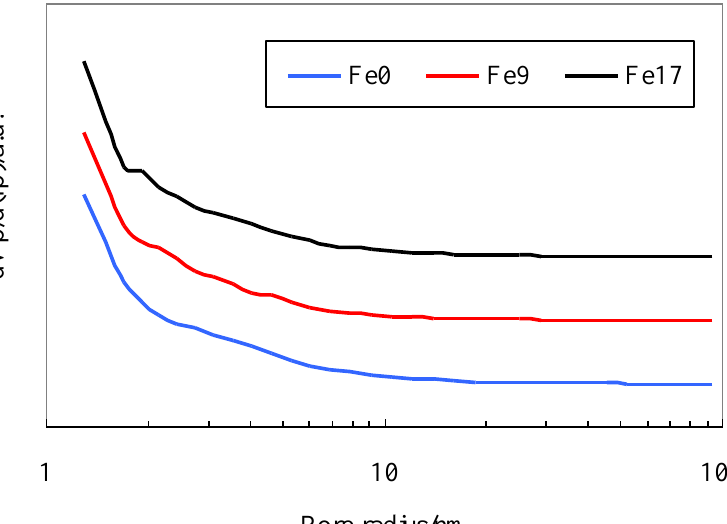
Figure 1. Pore distribution for activated